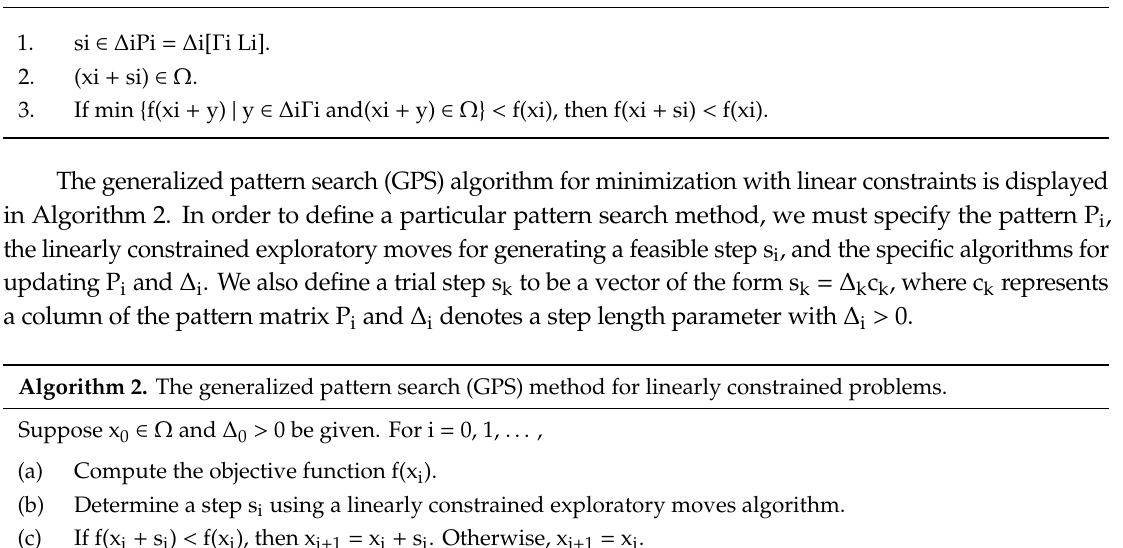
Algorithm 1. Exploratory moves for linearly constrained pattern search.